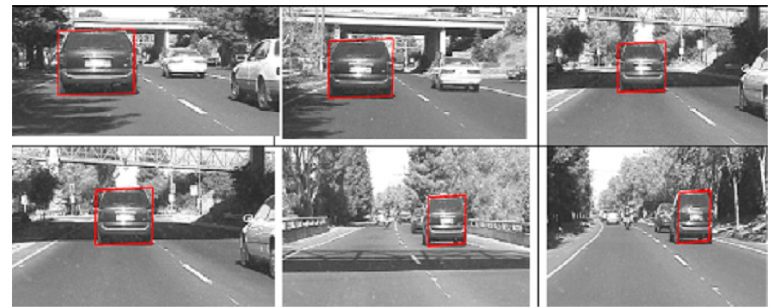
Figure 11. Tracking of a grayscale occluded vehicle (Data Set: Grayscale